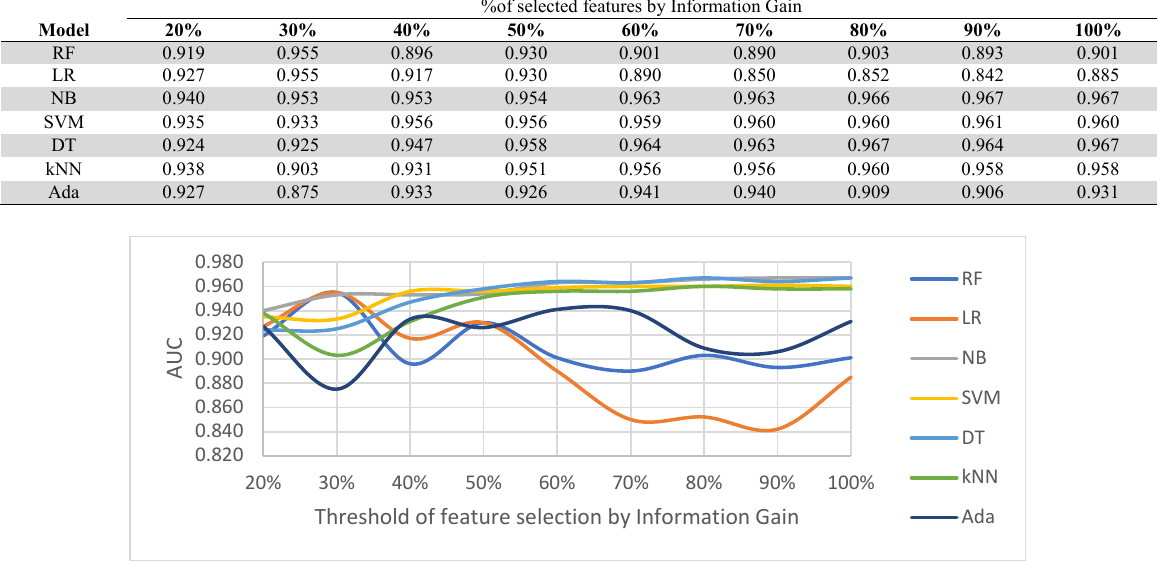
Fig. 5. AUC results for the comparison between different machine learning models using IG According to Fig. 5, it can be noticed that LR, RF, and Ada are the most unstable models, whereas NB and DT are the most stable models with slight changes in AUC while changing the selection threshold. Also, there is an improvement in AUC when selecting more features despite some selected features are irrelevant according to Information Gain. Finally, the kNN model shows less accurate AUC results when dealing with a small threshold value, but the AUC improves when the threshold value increases. To investigate more on why kNN behaves badly over small threshold values, the researchers have tried to change the number of k nearest neighbors from 1 to 10 but still, the best result for kNN is so far from other results for small threshold values. Another factor that may increase the accuracy of kNN is the choice of feature weights during the voting process. Two approaches were tried; the first approach is using equal weights for all retrieved k nearest neighbors and the second approach is to use their distance to increase the weight of some labels over others. The latter gives us better results. Indeed, searching for optimal configurations within a large space of configuration possibilities is a